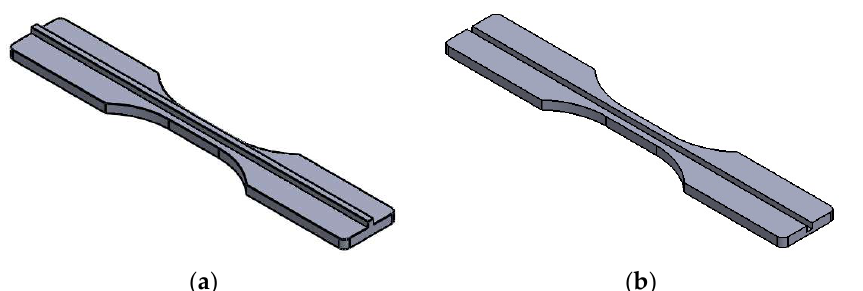
Figure 9. Schematic graph of cube inserts applied in overmolding processing: ( a ) male cube; ( b ) female cube.